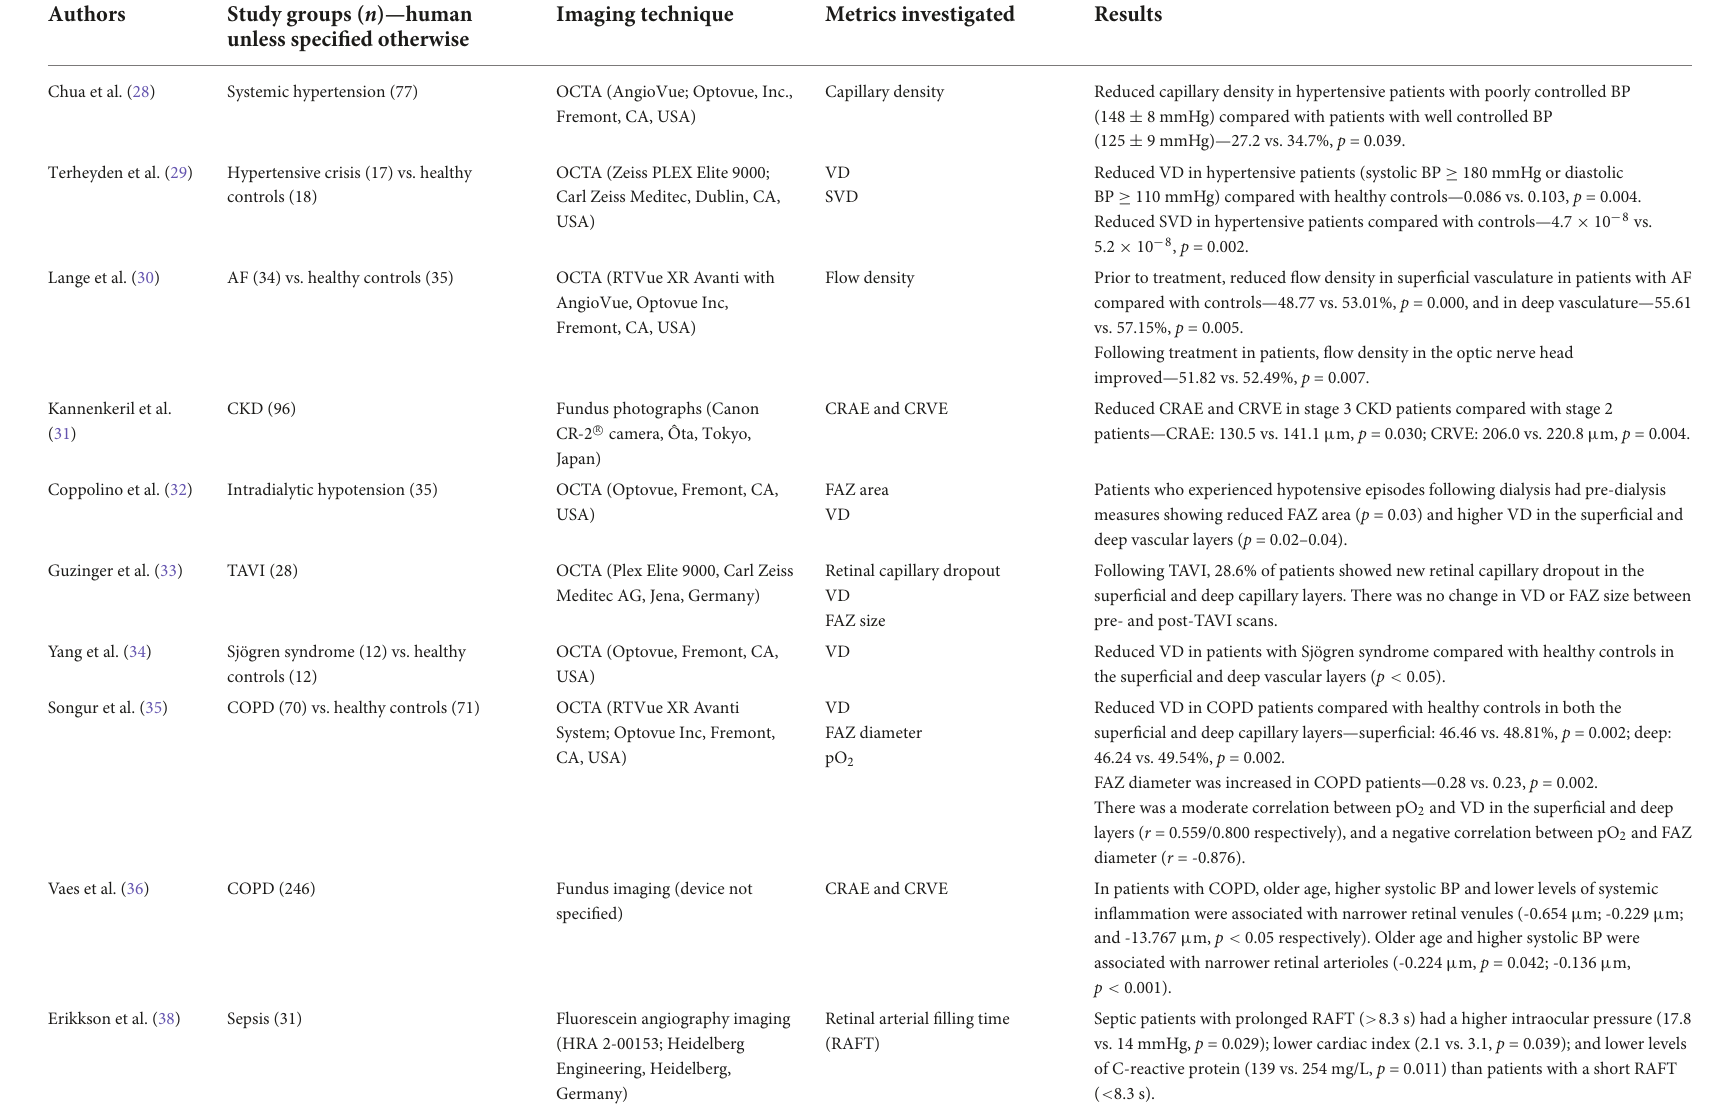
TABLE 1 Summary of studies investigating retinal blood flow changes in disease